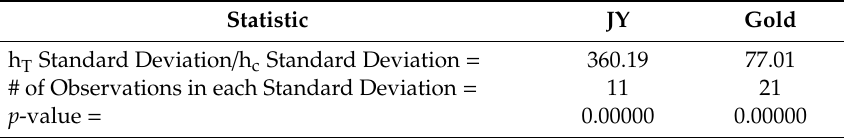
Table A5. Ratio of the HRs’ Standard Deviations (HRs based on Indian